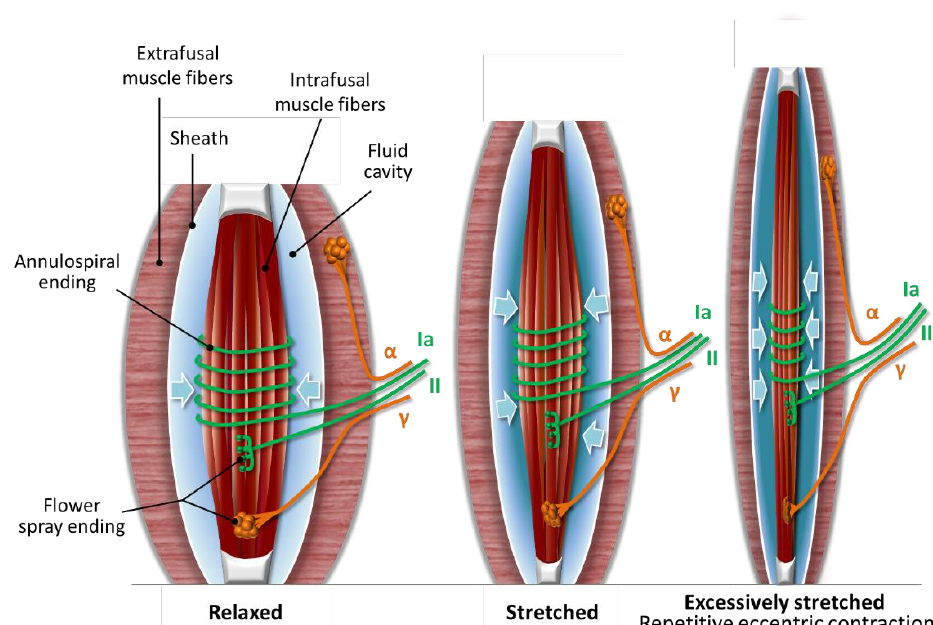
Figure 1. Three positions of the muscle spindle. (1) Relaxed muscle spindle: the more relaxed the muscle spindle is, the more relaxed the fluid cavity becomes; (2) Stretched muscle spindle: when the muscle spindle stretches, the fluid cavity flattens with uncompressible fluid inside, resulting in more compression and firing of the nerve terminals; (3) Excessively stretched muscle spindle: uncompressible fluid entraps and causes microinjury to the nerve terminals due to the superposition of compression when repetitive eccentric exercise is executed in an unaccustomed or strenuous way (drawn based on Colon’s description [6]).